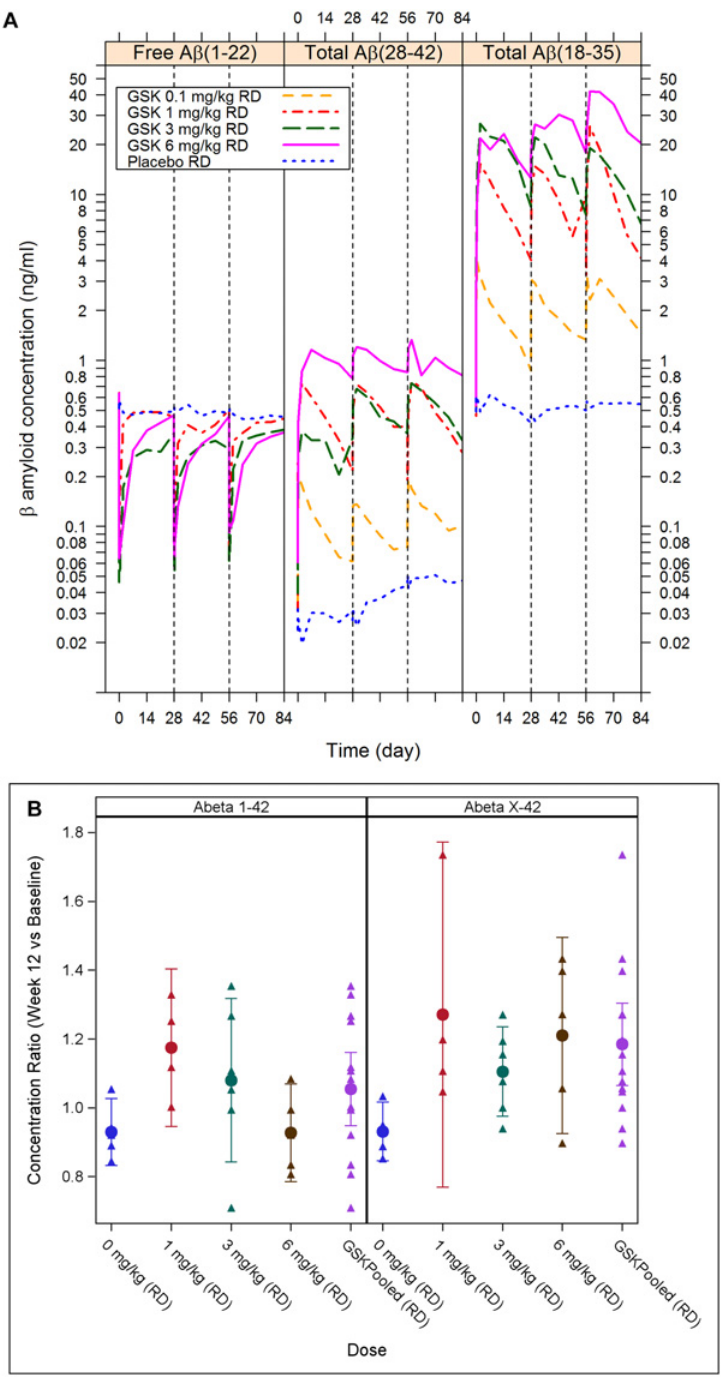
Fig 3. GSK933776 plasma pharmacodynamics. A) Geometric mean plasma A β concentration – time plots over the three dosing intervals (semi-log plot). Plasma levels of total A β 42 and A β increased whereas plasma levels of free A β decreased in dose-dependent manner. Peak:trough ratios for A β decreased with increasing dose of GSK933776. B) Week 12 ratio to baseline for CSF A β (A β 1 – 42 and A β X – 42) concentrations. Presented as individual values and mean (95%CI). There were no significant changes from baseline for A β 1 – 42 or A β X –